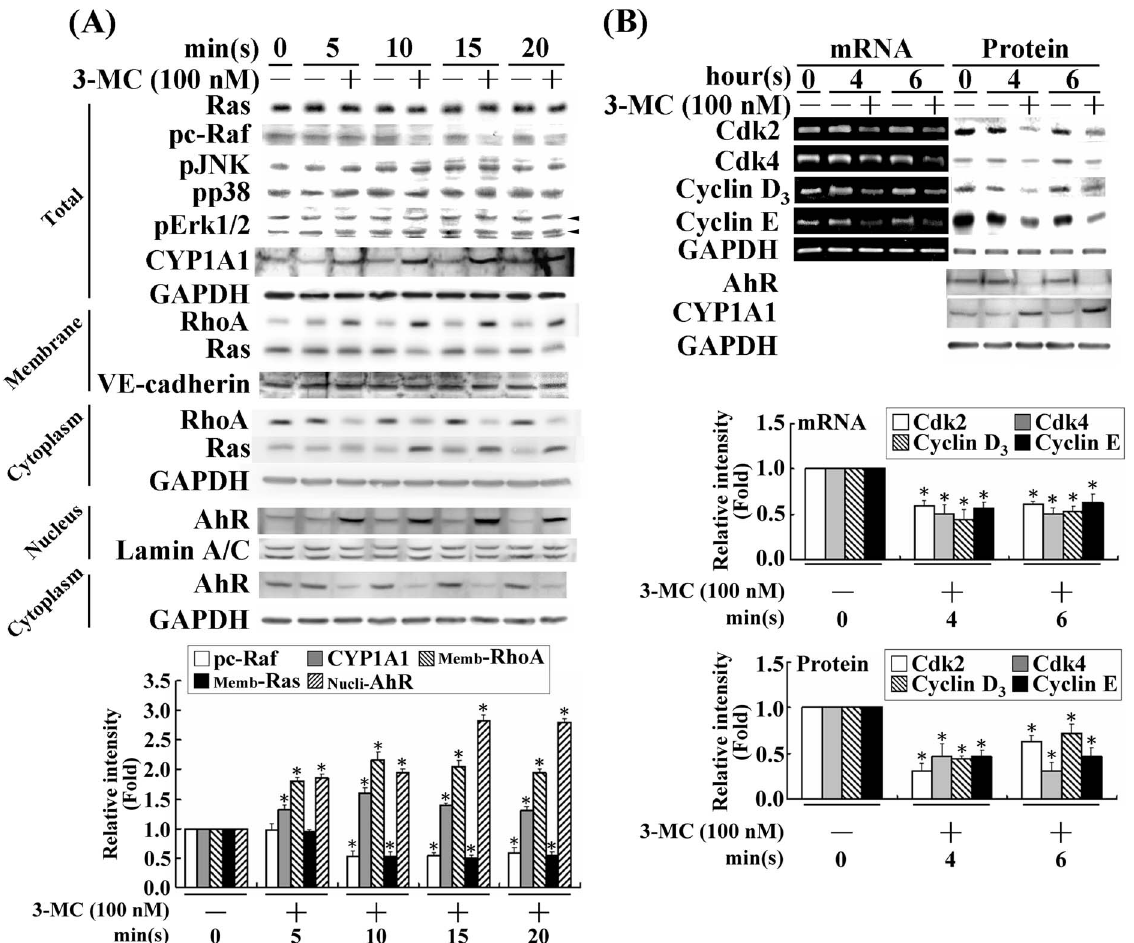
Figure 1. 3MC-mediated inactivation of Ras and c-Raf in relation to suppression of Cdk2/4 and Cyclin D3/E1 expression in MCVECs. (A) Cells were transiently challenged by 3MC (0 to 20 min) and then active forms of AhR, RhoA, Ras, c-Raf, and the MAPK family were analyzed using Western blot analysis of the indicated subcellular fractions. Anti-GAPDH, anti-Lamin A/C, and anti-VE-cadherin antibodies were used to verify the equivalent loading amounts of the cytosolic, nuclear, and membrane fractions, respectively. (B) Cells were treated with 3MC for a prolonged period (4 or 6 h) to investigate the effect of 3MC on cell-cycle regulatory proteins, including Cdk2/4 and Cyclin D3/E with CYP1A1 as a positive control for the AhR action of 3MC in Western blot analyses. Total RNA was extracted and analyzed, and GAPDH was used as an internal control. The data are presented as mean 6 SEM for 3 independent experiments ( * P , 0.05 vs. control group).